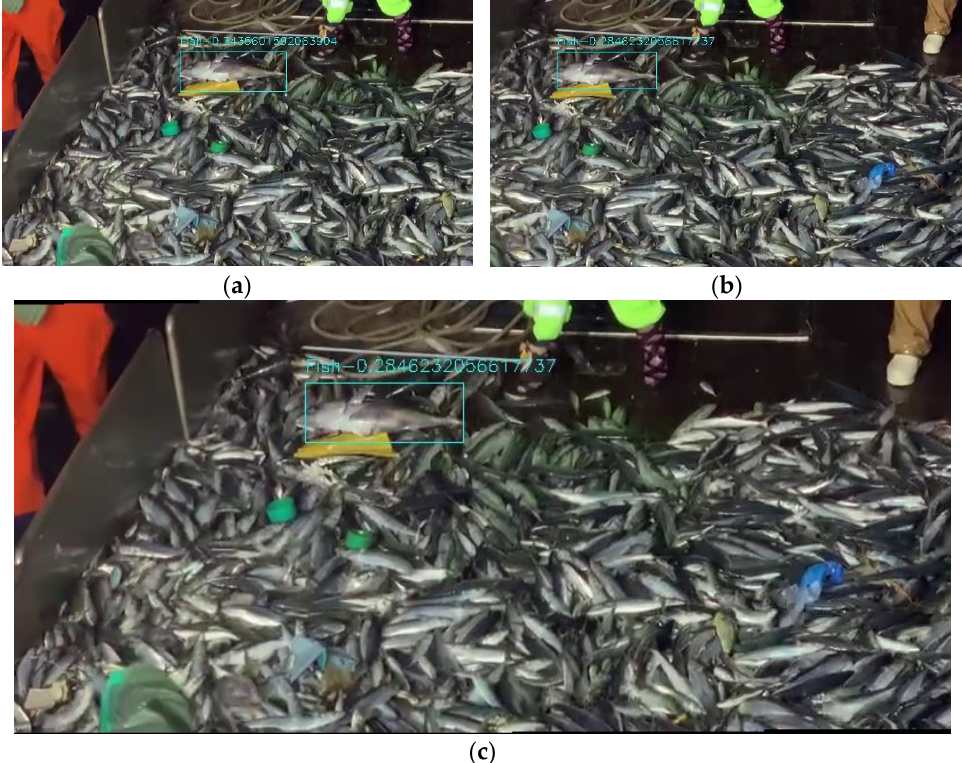
Figure 9. An example of combining image collections using stitching: ( a ) 80% of the 1 / 4 quadrant; ( b ) 80% of the 2 / 4 quadrant; and ( c ) results of the stitching technique.